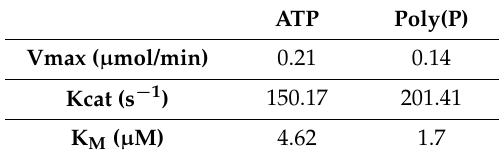
Table 1. Kinetic parameters of polyphosphate-dependent mannose kinase.